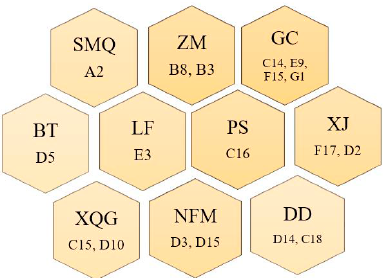
Figure 5. Special aromatic biomarkers (OAV > 0.2) based on HS-SPME-GC-MS data. The codes of the compounds correspond to those in Table 1.